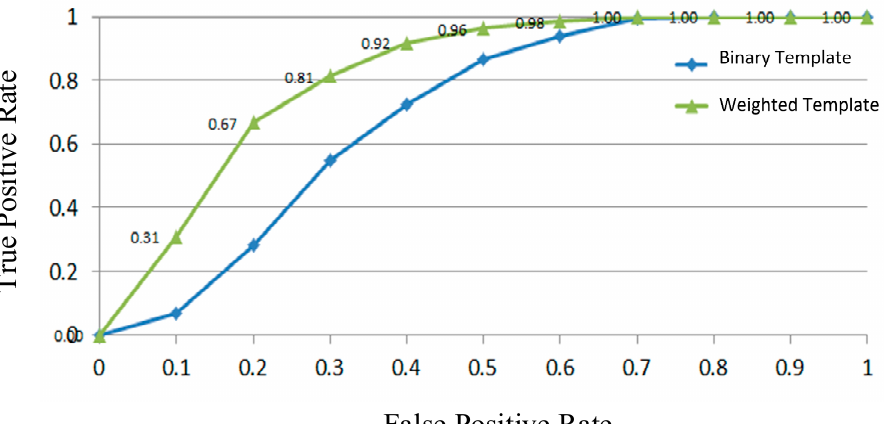
Figure 3. Performance comparison of the proposed global classifier H G ( . ) (green curve) with that (blue curve) only using binary contour templates for human classification.